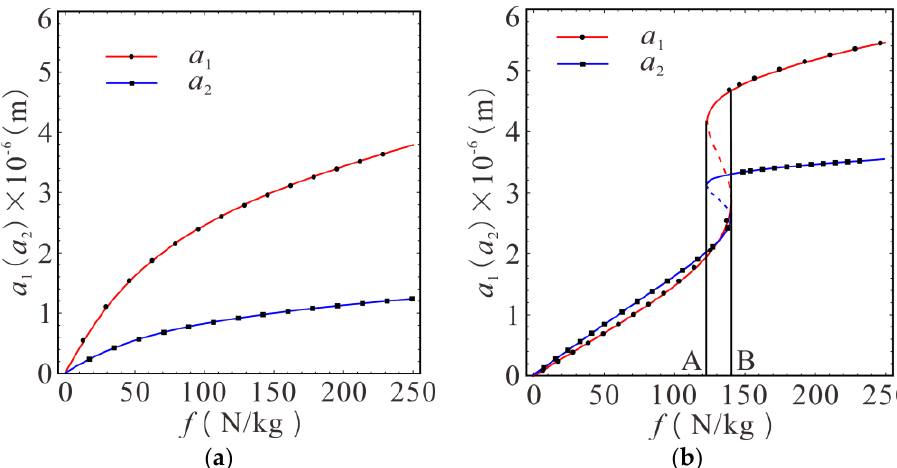
Figure 8. Relationship between the amplitude of the first-order and second-order drive modes and the electrostatic force amplitude. ( a ) The case of σ 1 = 0; ( b ) The case of σ 1 = 6.67 × 10 7 . The point was calculated using the numerical solution. The line was calculated using the MMS. The solid lines represent the stable solution. The dashed lines represent the unstable solution.